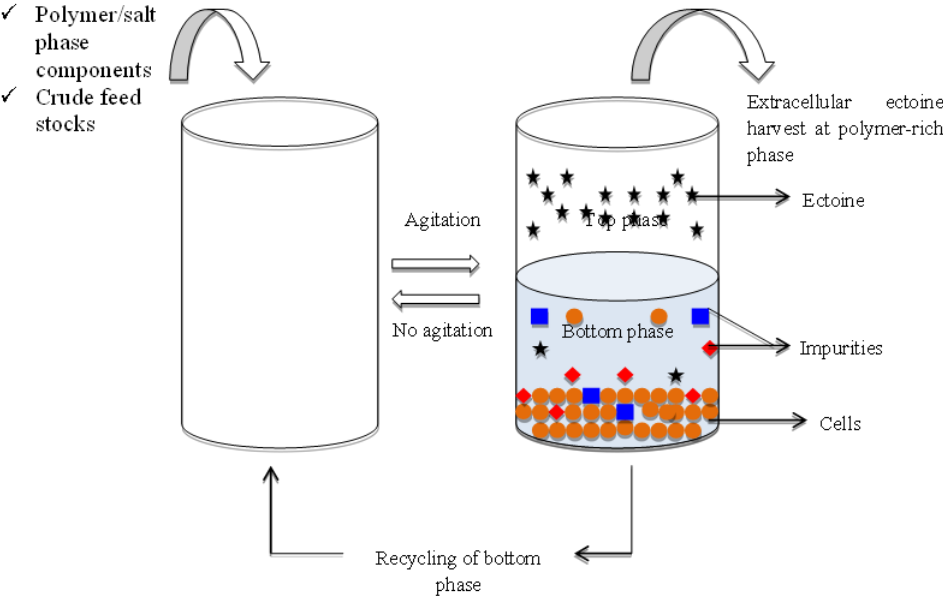
Figure 1. Schematic diagram on the proposed extractive fermentation of microbial ectoine with ABS. A process scheme was illustrated for continuous repetitive batch of extractive ABS fermentation for recovery of ectoine. The microbial cells is represented by “ (cid:11298)(cid:11299) ”, the ectoine is denoted by “ 🟊 ” and the impurities are denoted with “ ▄ ” and “ ◆ ”. In addition, simultaneous microbial cell disruption and ectoine recovery can be achieved by integrating the ABS into the extractive disruption of intracellular ectoine. The extractive ABS disruption is feasible by incorporating the ultrasonication, homogeniza- tion, or chemical cell disruption into the ABS recovery of the intracellular ectoine. Since most of the microorganisms tend to synthesize ectoine intracellularly, extractive ABS dis- ruption is regarded as a promising recovery strategy to integrate the cell disruption and ectoine recovery into a one-unit operation with enhanced yield and great cost efficiency. The schematic representation of the continuous, repetitive-batch extractive disruption of the intracellular ectoine-producing strain using the ABS is illustrated in Figure 2.